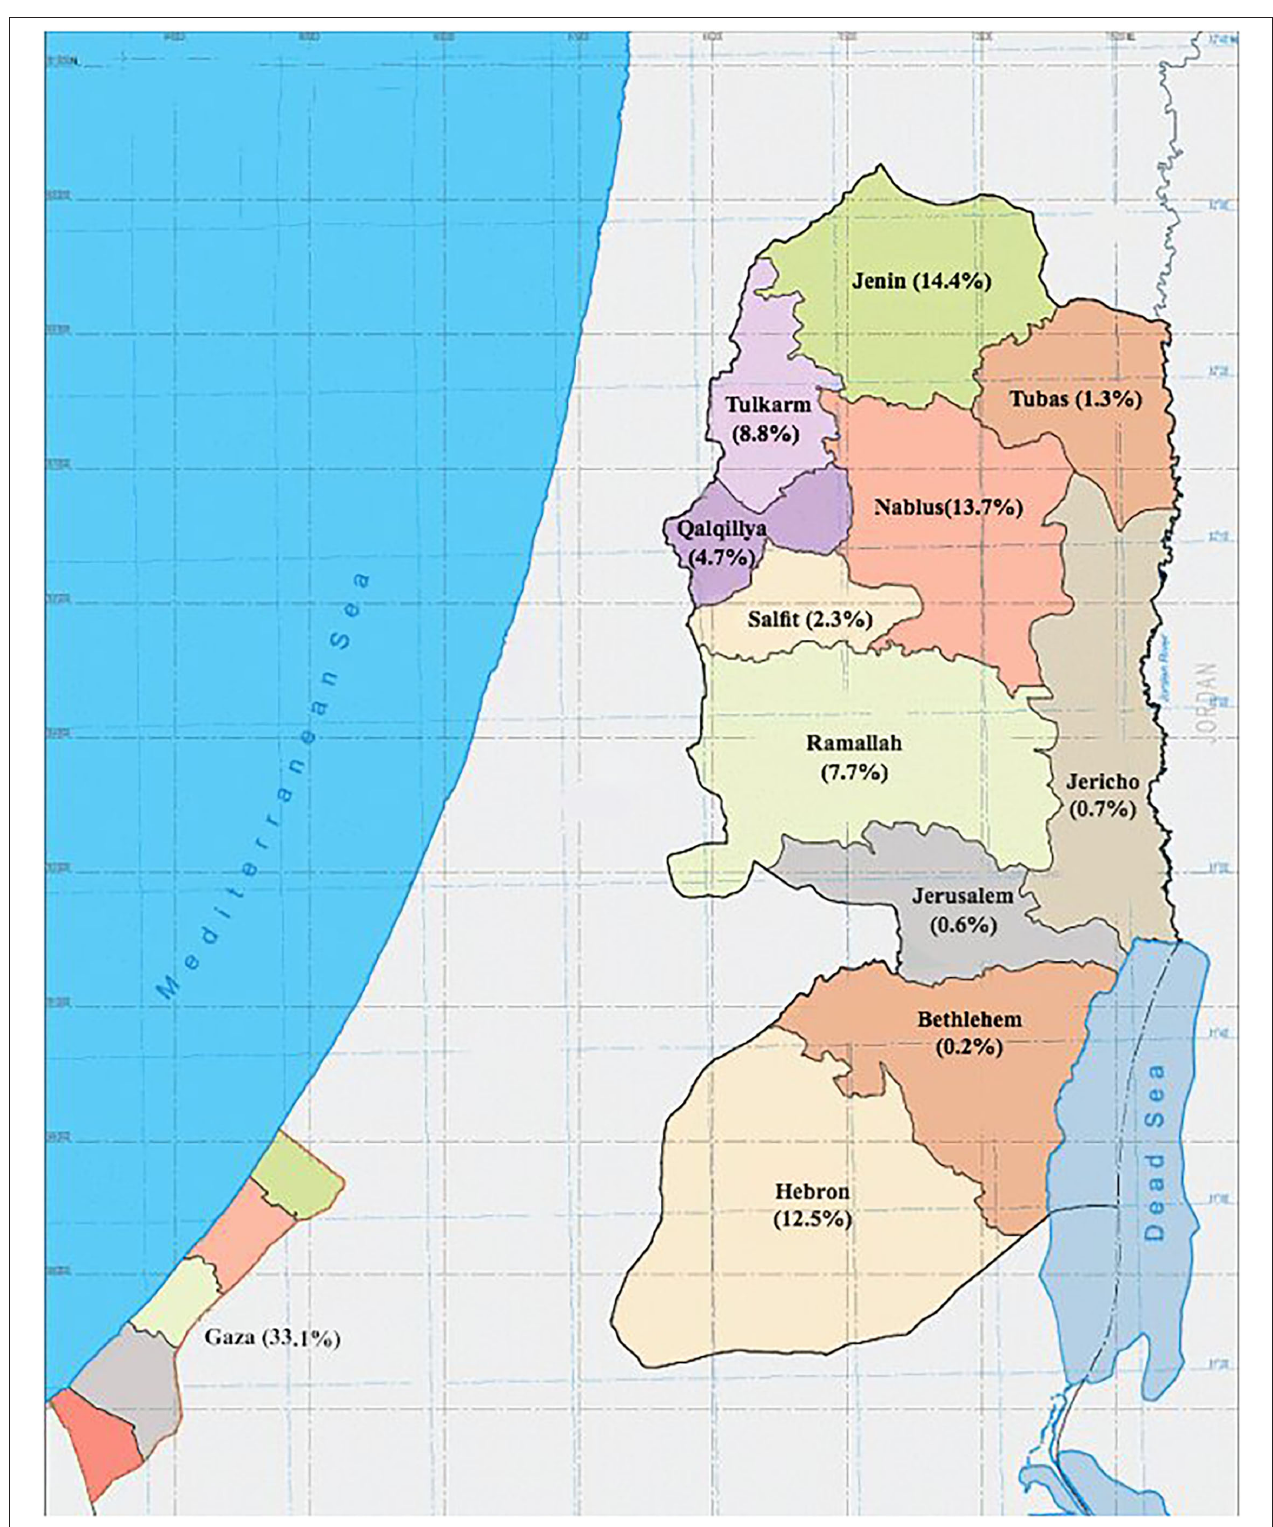
FIGURE 1 | Map of Palestine showing the geographical distribution of patients with β -thalassemia registered in the Thalassemia Patients’ Friends Society (TPFS), 2018.